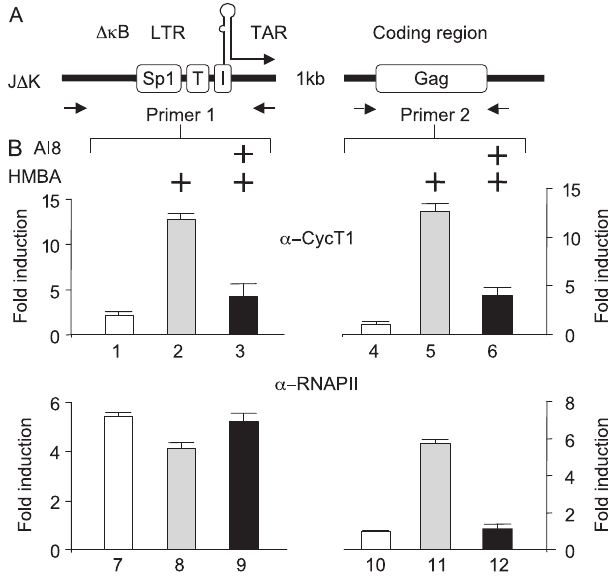
Figure 4. HMBA Induces the Recruitment of P-TEFb to the HIV Promoter (A) Schematic representation of the HIV promoter (LTR) and coding region (Gag). Lack of NF- j B sites is denoted by Dj B. LTR: long terminal repeat; Sp1: 3 Sp1 binding sites; T: TATA box; I: initiator; TAR, transactivation response element; Gag: group specific antigen. (B) J D K cells, chronically infected with HIV-1 lacking NF- j B binding sites, were pre-treated or not with AI8 prior to the stimulation with HMBA (5 mM, 1 h) and proteins were fixed onto DNA with formaldehyde. Following sonication, the anti-CycT1 or anti-RNAPII antibodies were added to the chromatin solution for immunoprecipitation of DNA– protein complexes. PCR was performed with the indicated primers (A) to analyze amounts of DNA that were associated with CycT1 or RNAPII at the promoter (primer 1) or 1,000 nt downstream in the Gag gene (primer 2). Quantitative PCRs were performed with anti-RNAPII or anti-CycT1- immunoprecipitated samples, as well as with input DNA before immunoprecipitation, which served as controls for the amplification efficiency of individual sets of PCR primers. Immunoprecipitates obtained without using any antibody were used as negative controls.